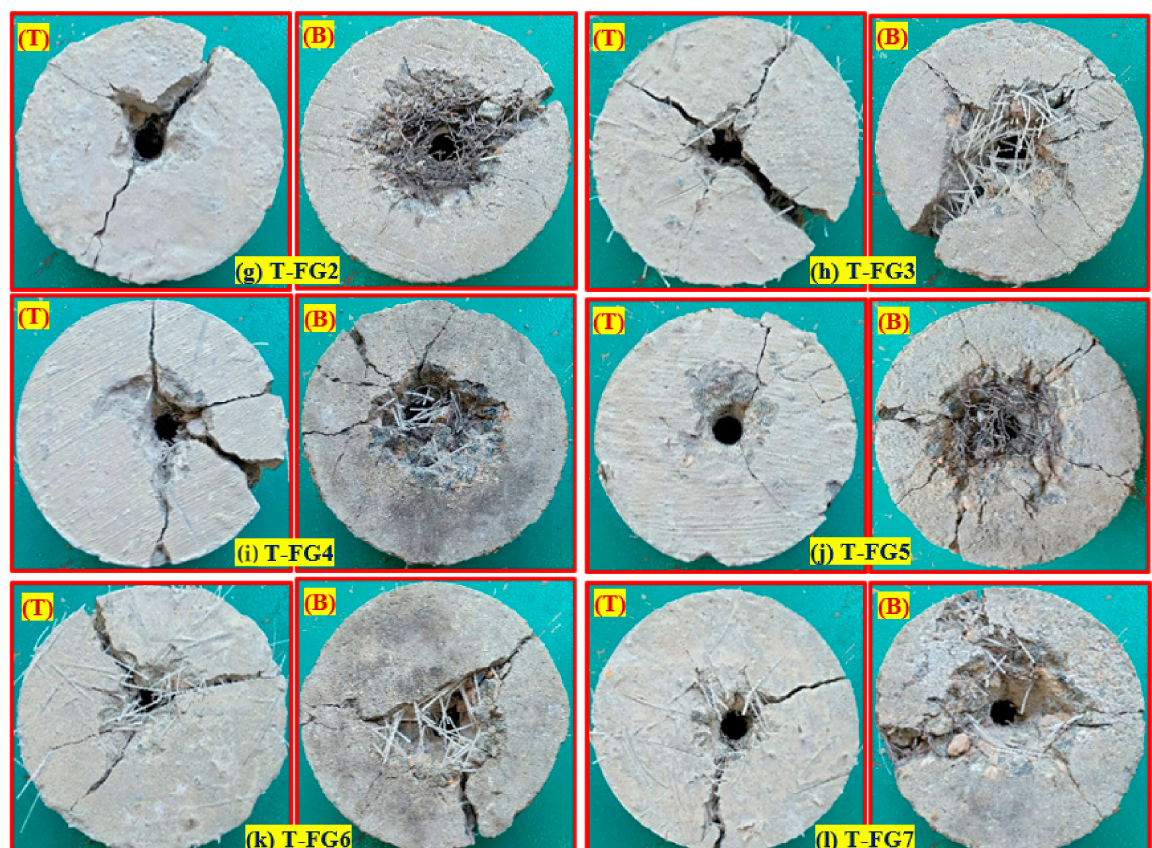
Figure 16. Appearance of specimen failure under HE